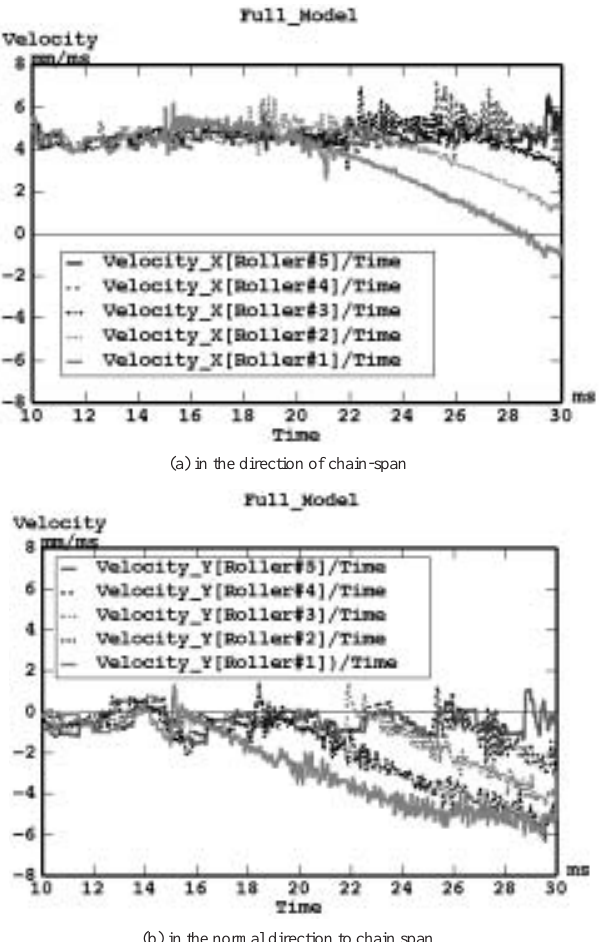
Fig. 7. Velocity response of five rollers engaging successively with driving sprocket: full